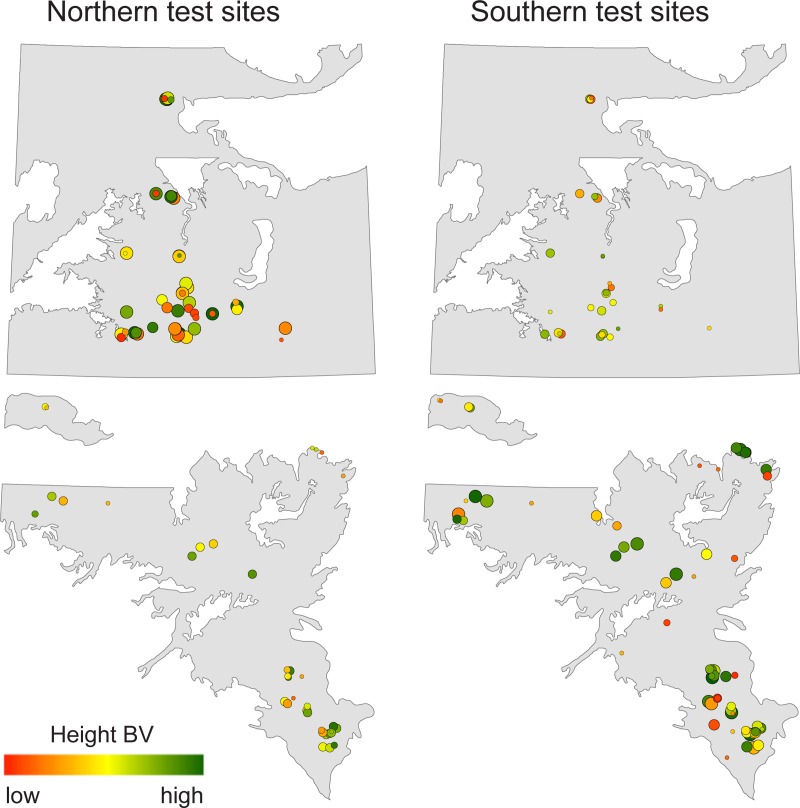
Height breeding values (BV) of parents tested northern breeding region test sites (left panel) and the southern breeding region sites (right panel). The size of the circle indicates the reliability of the estimate (reliability: 0.1 = small circles, 0.7 = large circles). The color spectrum of red to green indicating low to high BVs, with values ranging from -55 to 45 cm. Map data was obtained from https://open.alberta.ca/opendata.